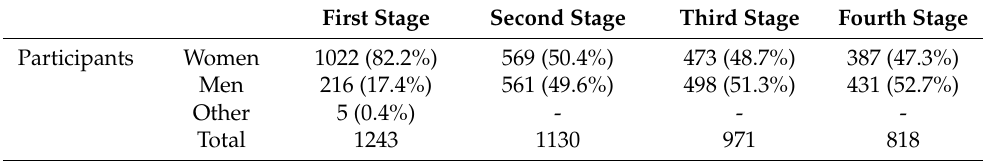
Table 1. Number of participants in each stage divided by gender.